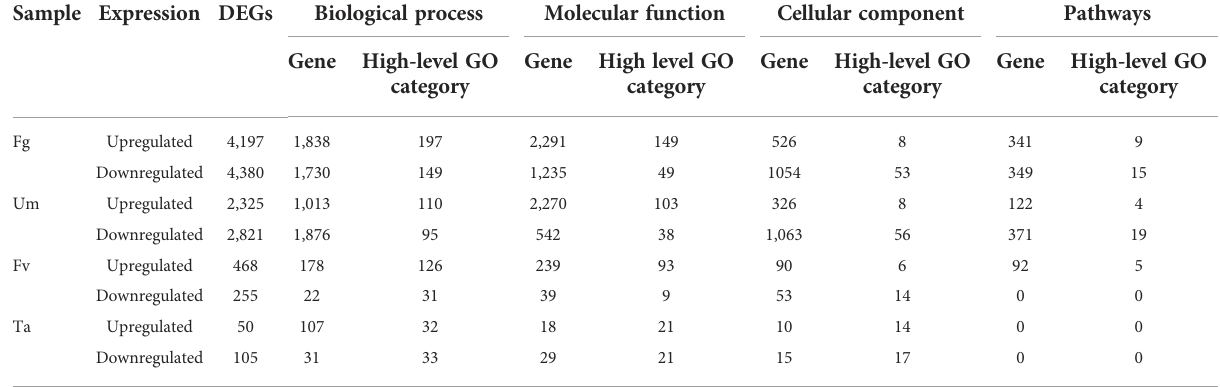
TABLE 3 Gene set enrichment analysis of DEGs. Sample Expression